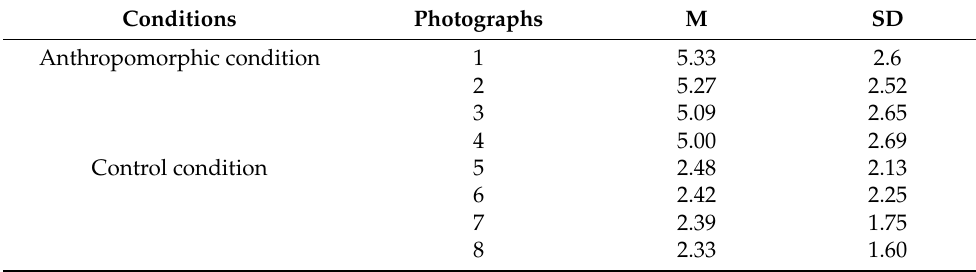
Table 1. The results for anthropomorphic photograph